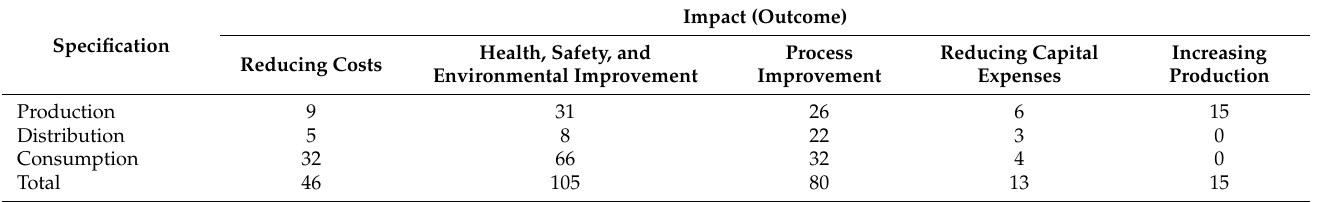
Table 3. The impacts of digitalization with respect to energy production, distribution, and consumption 1 .